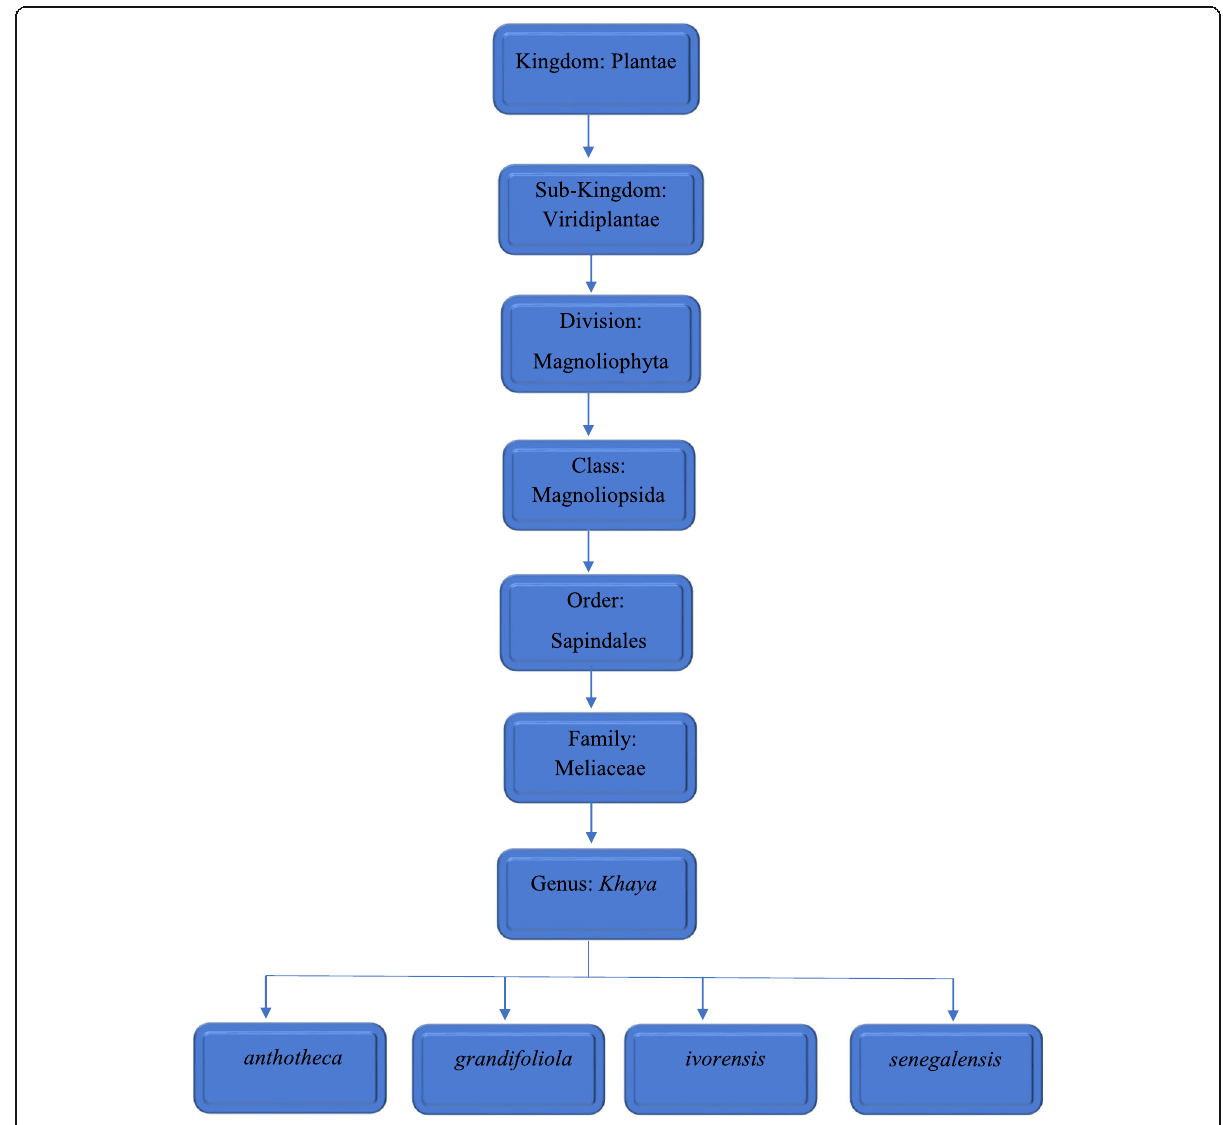
Fig. 1 Scientific classification of Khaya